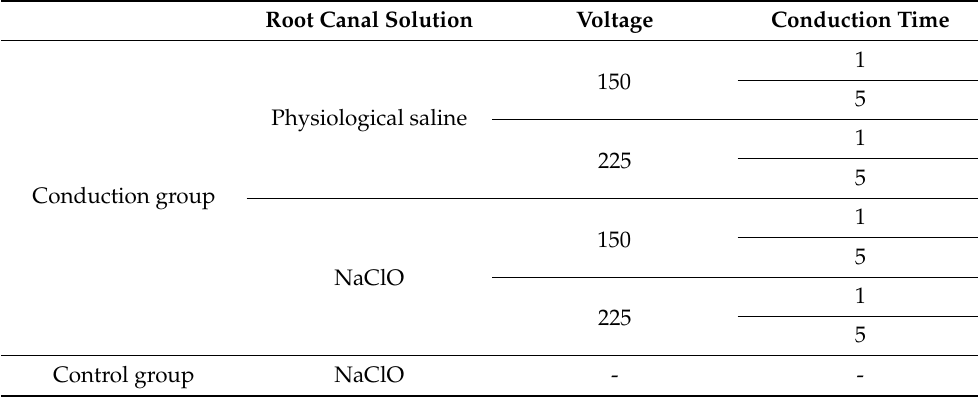
Figure 3. Classi fi cation of simulated root canal wall by discoloration.